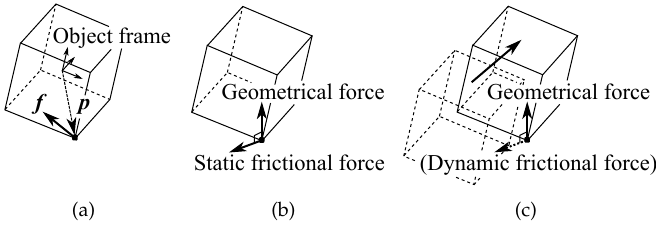
Figure 6. Force applied on a point of contact. ( a ) Definition of force. ( b ) Type of forces applied on a contact when the contact is fixed. ( c ) Types of forces applied on a contact when the contact is sliding.